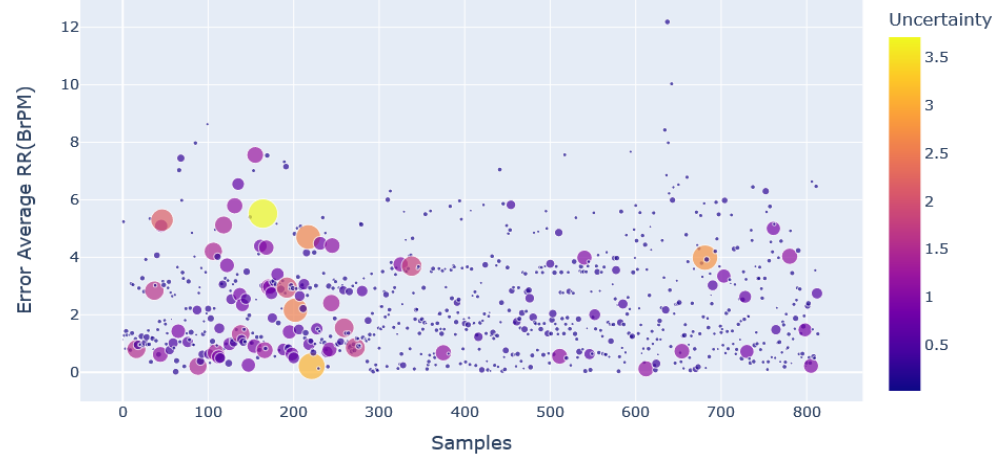
Figure 7. Scatter plot of uncertainty distribution with respect to error in average RR prediction.